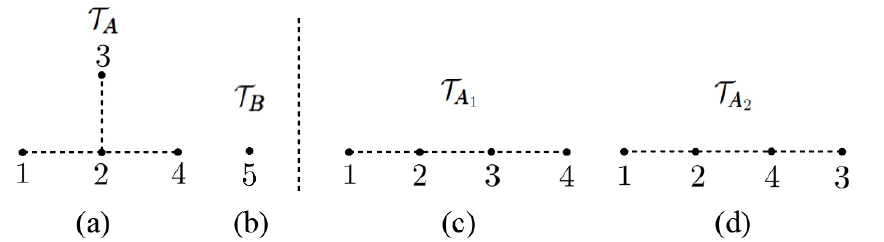
Figure 3 . The graph (a) is a star graph while (b) is a single node. If the T AAA and T BBB in the graph-based BCJ relation are respectively chosen as (a) and (b), the T two simple chains (c) and (d),